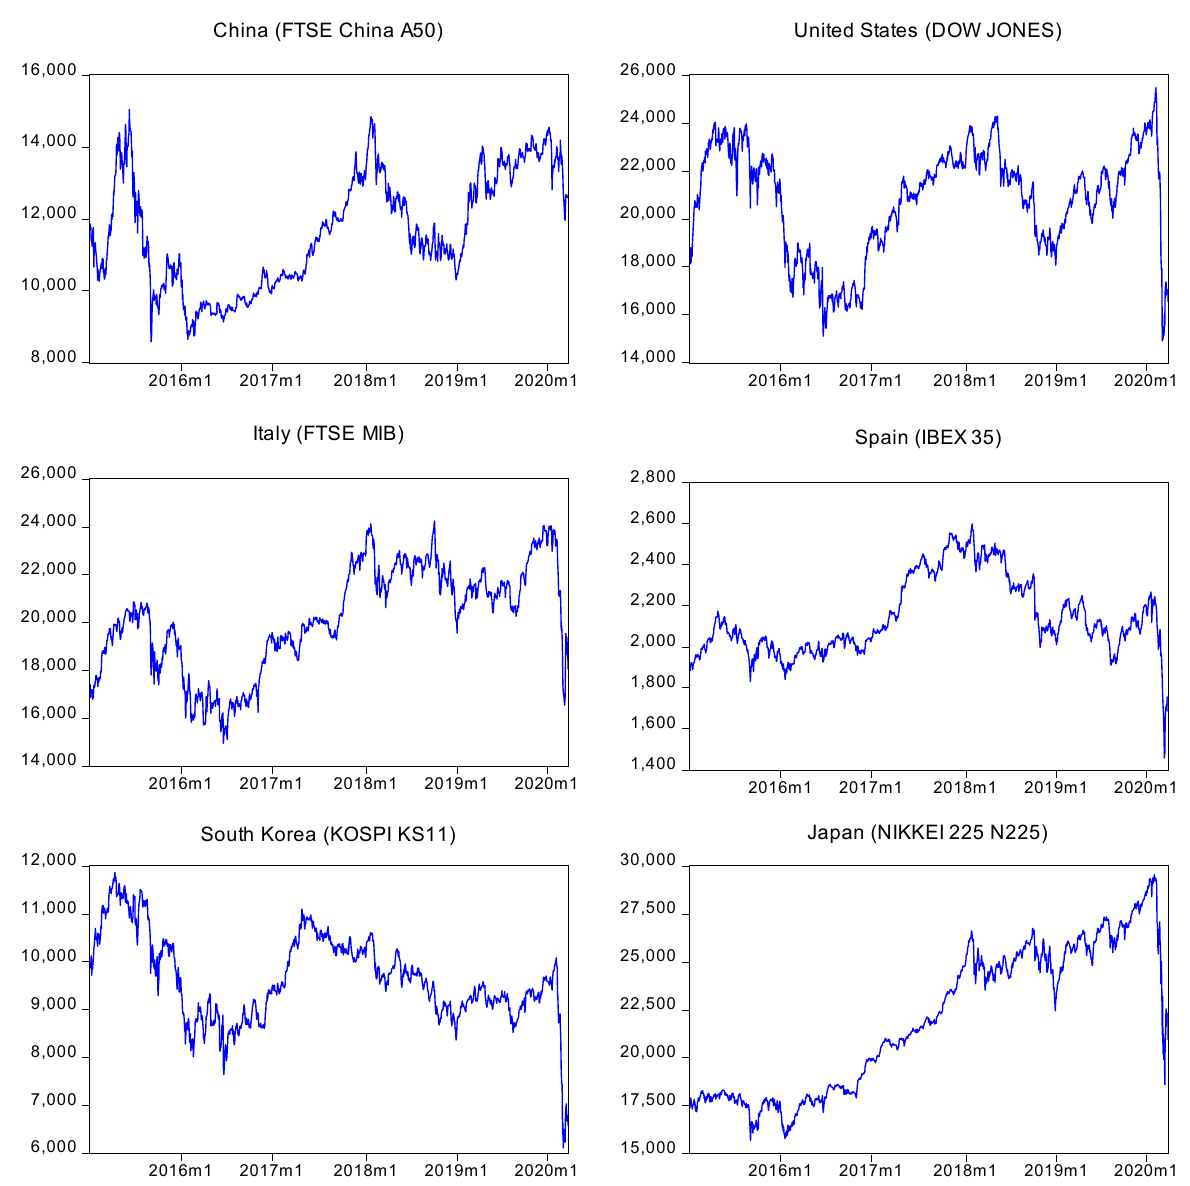
Figure 1. Stock market prices in local currencies. Source: Data Stream (2020). The decrease in the stock market prices corresponds with the surge in the overall number of people contaminated per day in each country (see Figure 2), where the first transmission pattern is appointed to the factor of close contact with infected individuals. The behavior of the absolute number of people infected per day in these countries suggests an inverse correlation with the stock market returns. The number of people contaminated per day is shown ahead, and the increasing trend is evident. China is considered the best performer to control the virus spread rate. The rest of the countries are struggling to keep the curve plane; however, Japan and United States have the largest contamination speed considering that the outbreak on a large scale started in February (even when the first case was detected earlier).